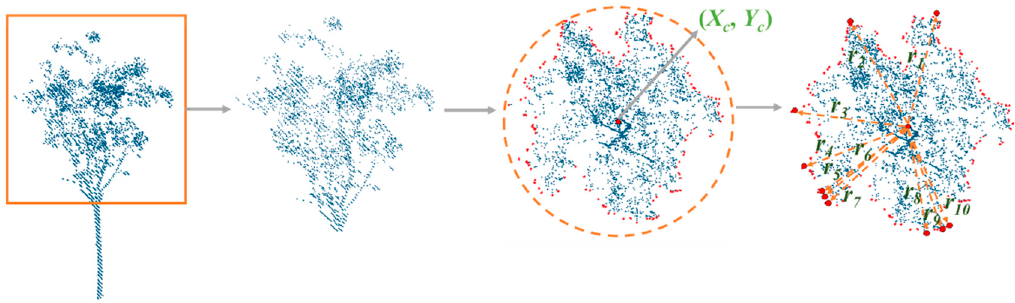
Figure 10. Crown width measuring method.